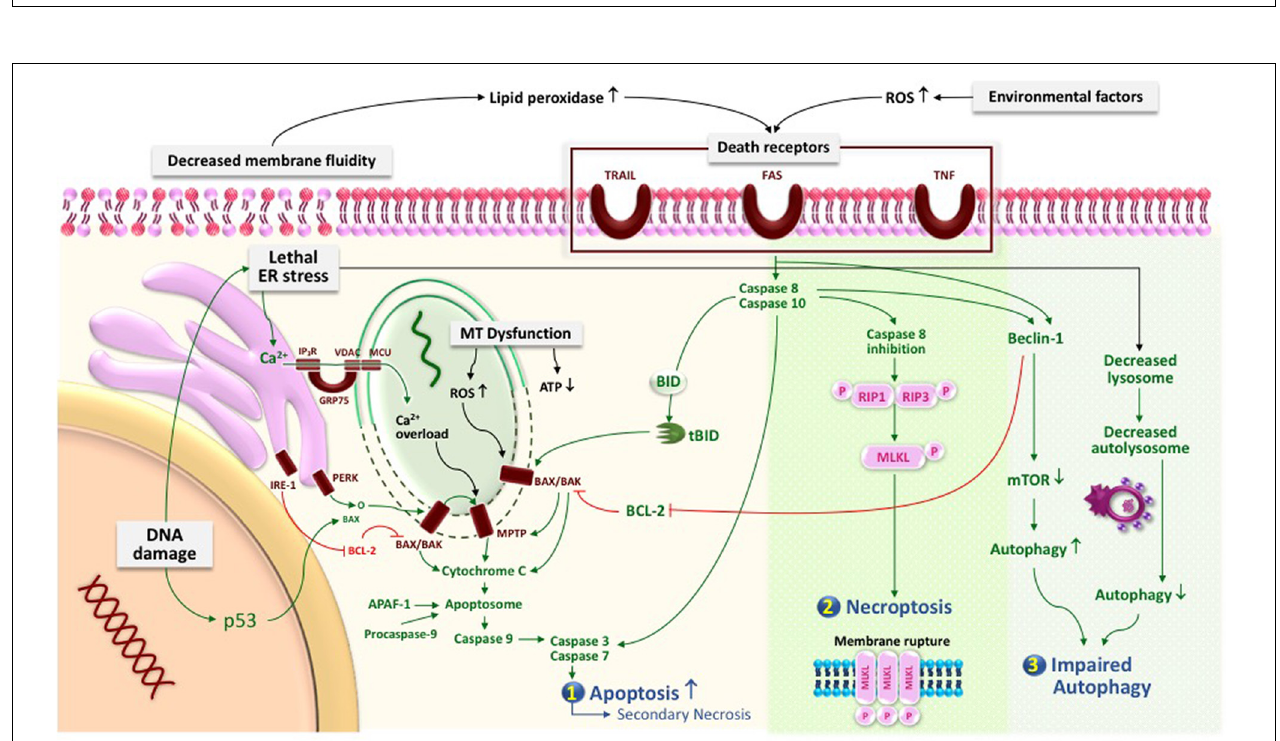
FIGURE 2 | Inappropriate cell death pathways in a trophoblast cell in preeclampsia. Damaged organelles (DNA damage, lethal ER stress, mitochondrial dysfunction, and cell membrane) in trophoblast cell in preeclampsia results in inappropriate cell death: (1) apoptosis, (2) necroptosis, and (3) autophagy.